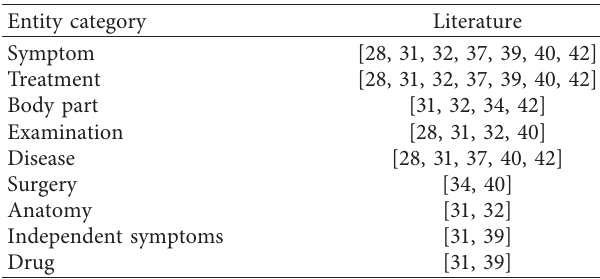
Table 1: Sorting of entities.